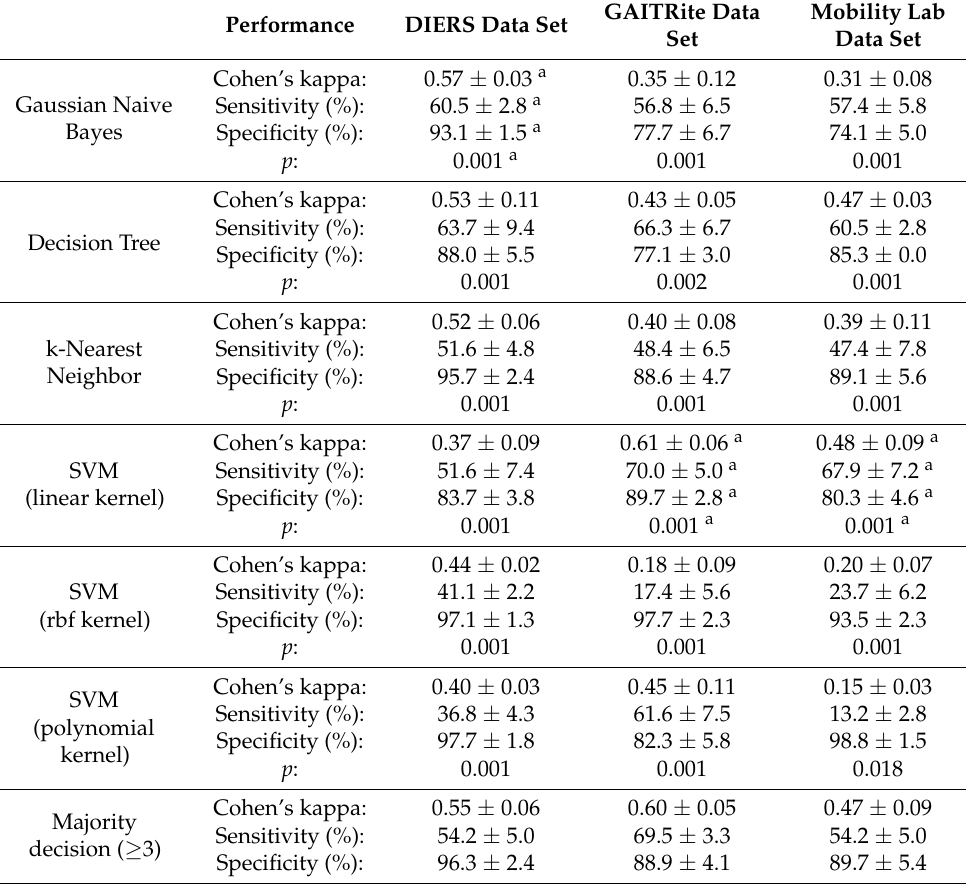
Table 8. Performance of the six classification models on the detection of mild EDSS or moderate EDSS in people with multiple sclerosis ( n = 54) after hyperparameter optimization and feature selection. In addition, the majority decision of all six models is shown. A majority decision for a positive label occurs when at least three models ( ≥ 3) predicted the positive class. The values are presented as mean ± standard deviation across 10 times 5-fold cross-validation repetition. Sensitivity and specificity were used instead of the accuracy due to imbalanced data (65% mild, 35% moderate). a Best overall performance per category for each data set; SVM = Support Vector Machine; rbf = radial basis function; p -value via permutation test. DIERS Data